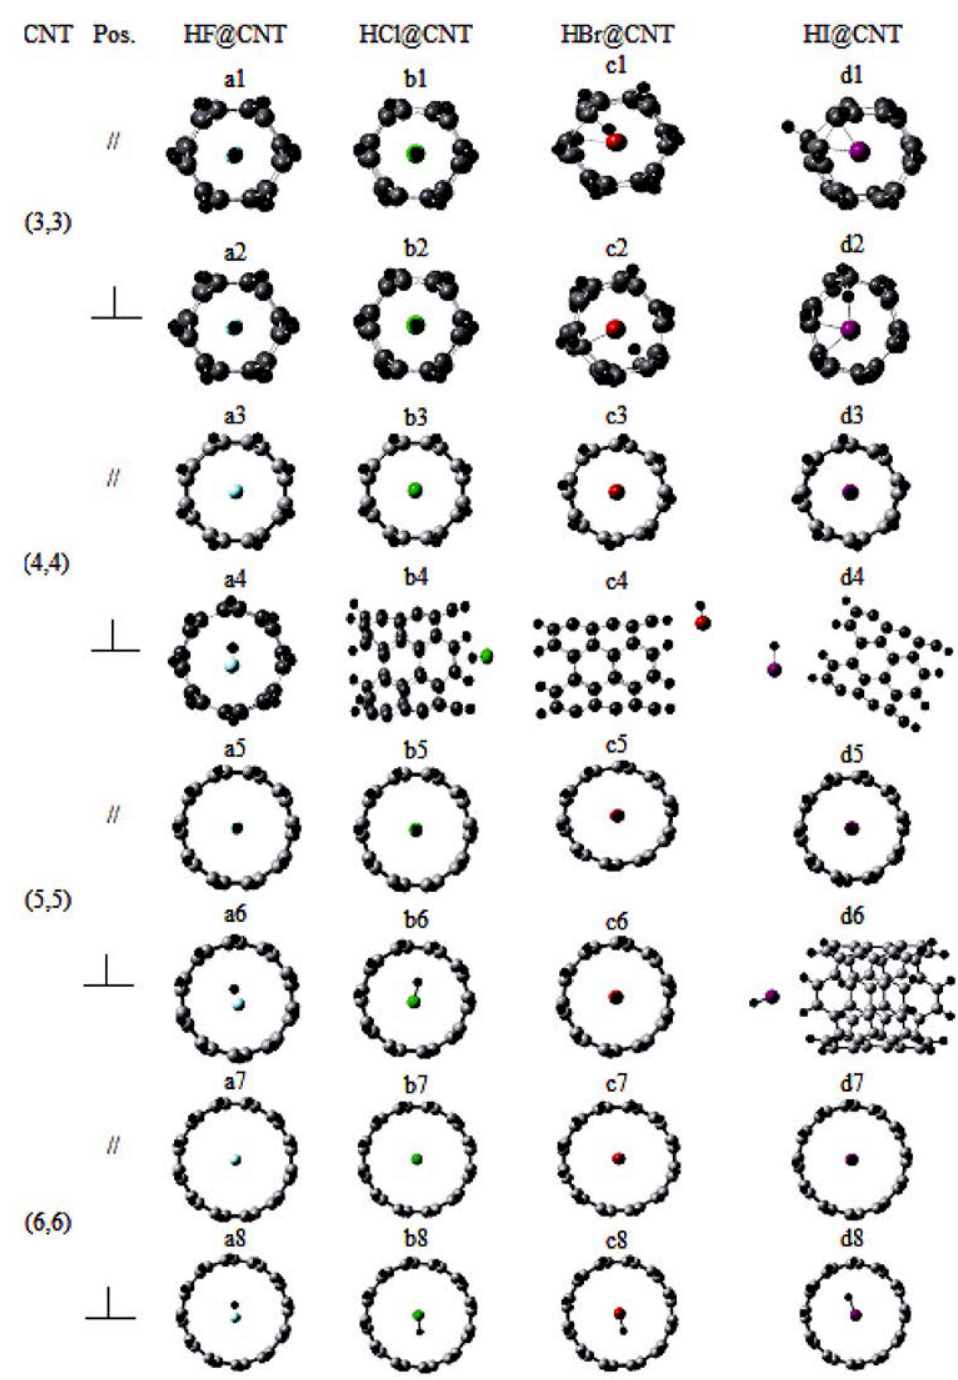
Figure 2. Interaction of HX molecules with the (3,3), (4,4), (5,5) and (6 ,6) CNT’s at both parallel and perpendicular